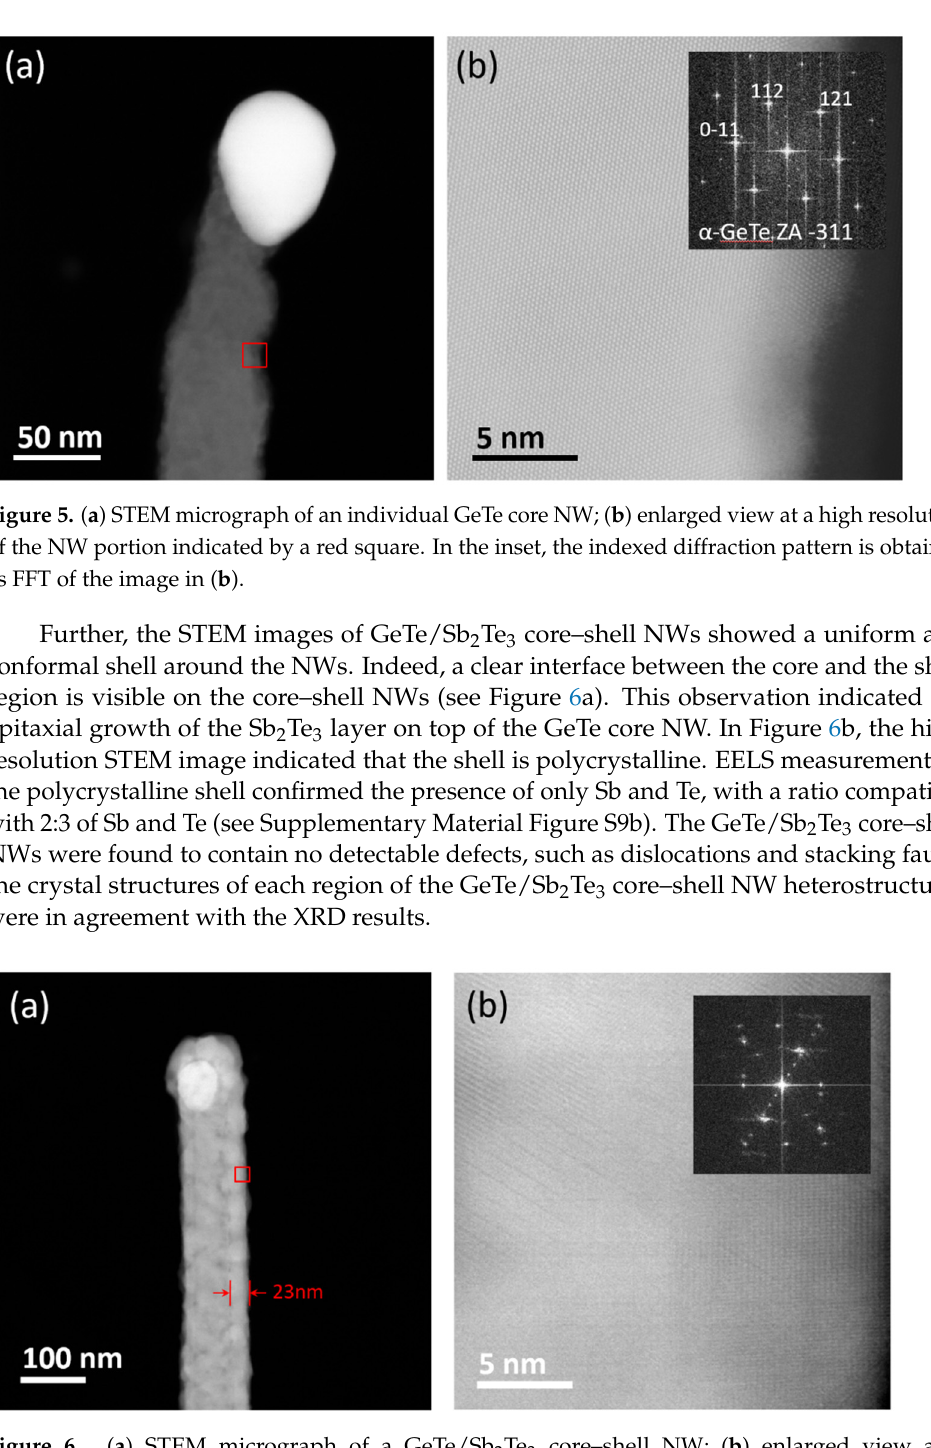
Figure 6. ( a ) STEM micrograph of a GeTe/Sb 2 Te 3 core–shell NW; ( b ) enlarged view at a high resolution of the shell (red square) and the corresponding FFT in the inset, showing its polycrystalline nature.